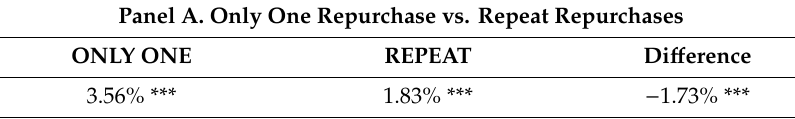
Table 3. Cumulative abnormal announcement returns (0, + 1).